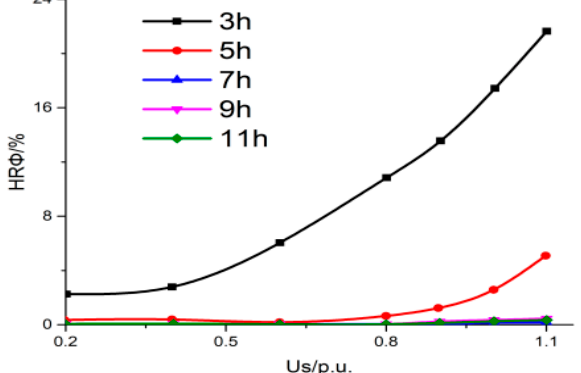
Figure 14. Variation trend of phase flux harmonic content.